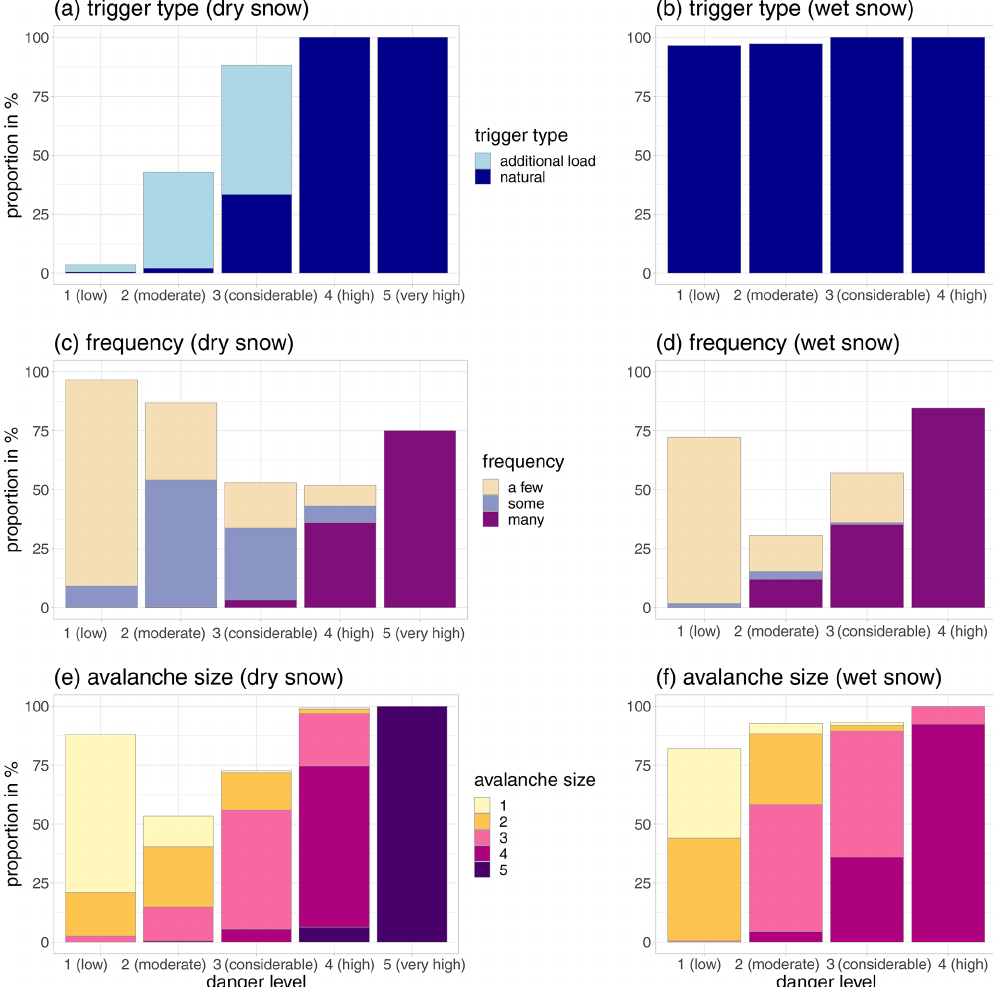
Figure 5. Bar plots showing the proportions for the terms characterizing the three key factors by danger level. The left column (a, c, e) shows the distributions for dry-snow conditions and the right column (b, d, f) for wet-snow conditions. The upper row (a, b) shows the trigger, the middle row (c, d) the frequency of triggering spots, and the lower row (e, f) the avalanche size. No data for wet-snow conditions for danger level 5 (very